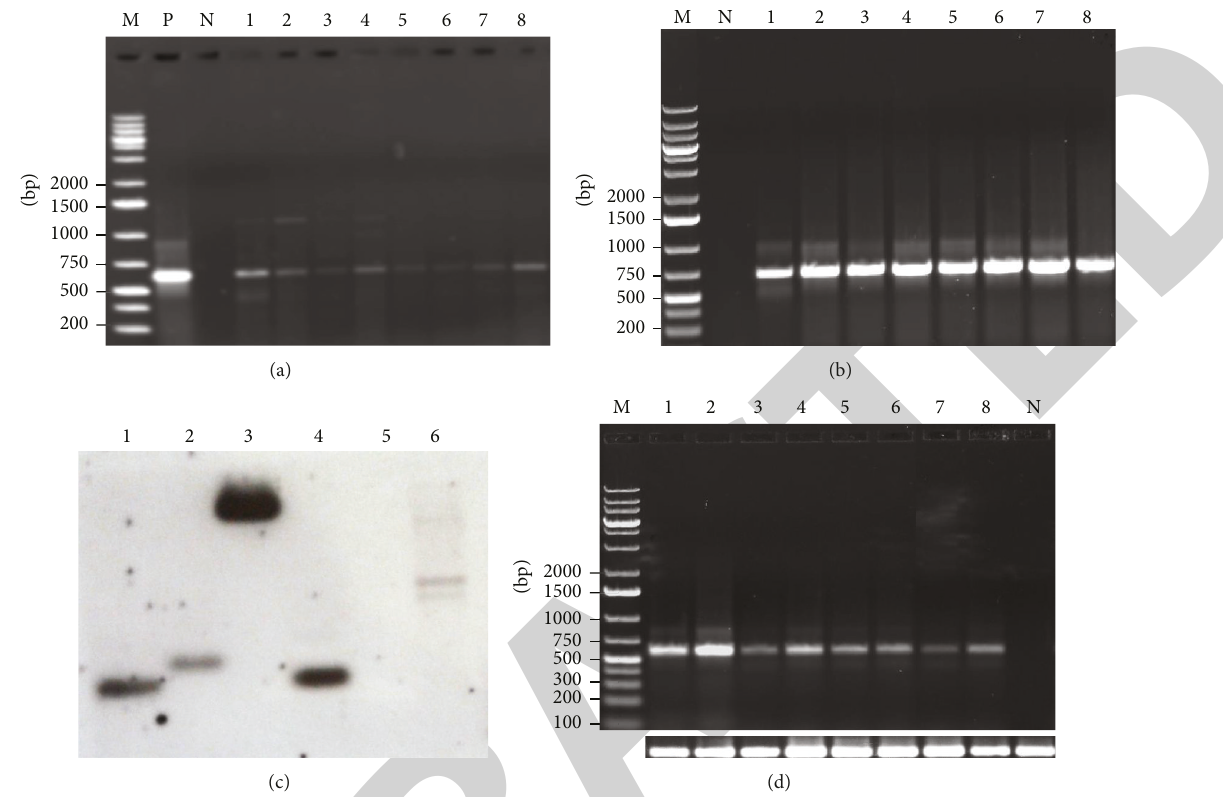
Figure 3: Molecular characterization of mtlD peanut transformants. (a) PCR amplification using mtlD gene-specific primers (expected size 600 bp); (b) PCR amplification of transformants using npt II gene specific primers (expected size 750 bp), where lane N: negative control; lane P: positive control (pCAMBIA1380 plasmid DNA); and lanes 1–8: transgenic lines (MTD1 to MTD8); (c) Southern blot analysis of transgenic (T 0 ) and nontransformed peanut lines. Where lanes 1–4: DNA from transgenic lines, lane 5: DNA from nontransformed line (cv. GG 20, − ve control), and lane 6: plasmid DNA (+ve control); (d) detection of mtlD gene transcription in transgenic plants using RT-PCR. Lane N = nontransformed line; lanes 1–8 = transgenic lines (MTD1 to MTD8), bottom row: 18SrRNA as internal control.